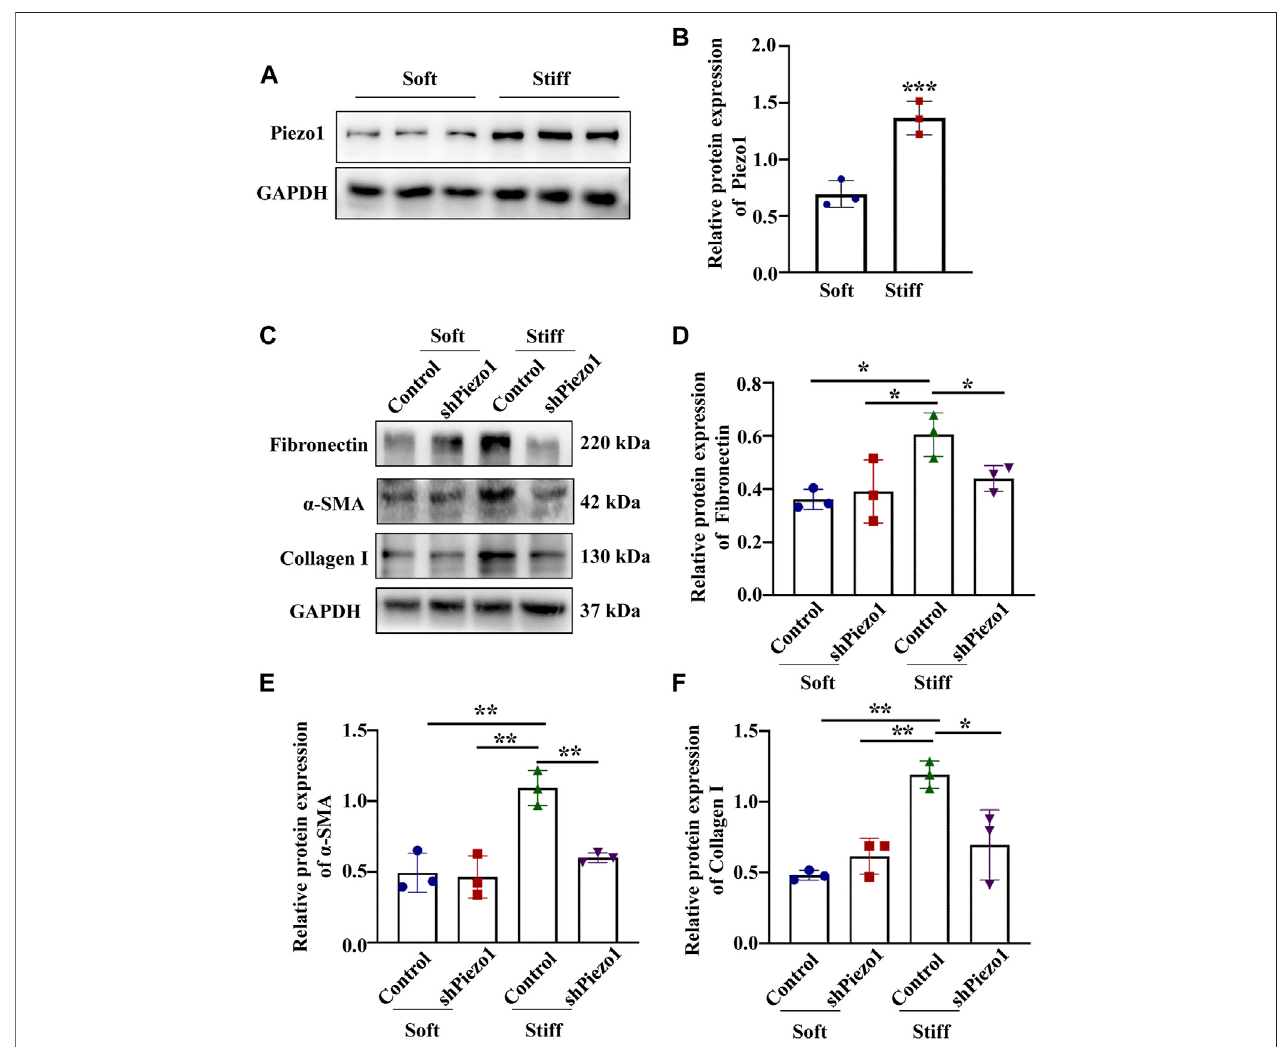
FIGURE5| Piezo1knockdownreducedECMproteinlevels. (A) RepresentativewesternblotbandsofPiezo1inMCsculturedonhydrogelswithastiffnessof2 kPa or50 kPafor48 h. (B) Thebargraphsshowtheresultsofsemi-quantitativemeasurementofPiezo1( n (cid:1) 6;* p < 0.05,** p < 0.01,*** p < 0.001). (C) MCsweretransfected with shNC or sh Piezo1 and grown on soft and stiff gels. Representative western blot bands of Fibronectin, α -SMA and Collagen I. The bar graph shows the result of semi-quantitative measurement of Fibronectin (D) , α -SMA (E) and Collagen I (F) . ( n (cid:1) 3; * p < 0.05, ** p < 0.01, *** p < 0.001).